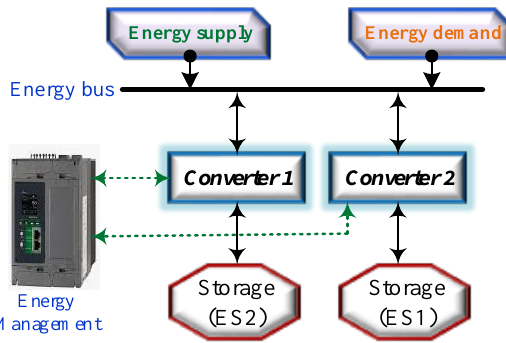
Figure 8. The basic architecture of HESS.